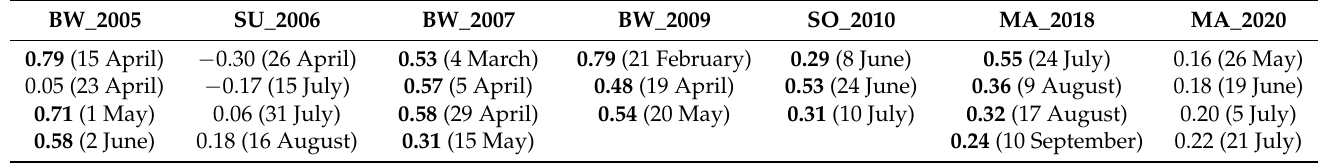
Table 10. Pearson’s correlations (r values) between NDVI data in different acquisition dates and crop yields ( n =